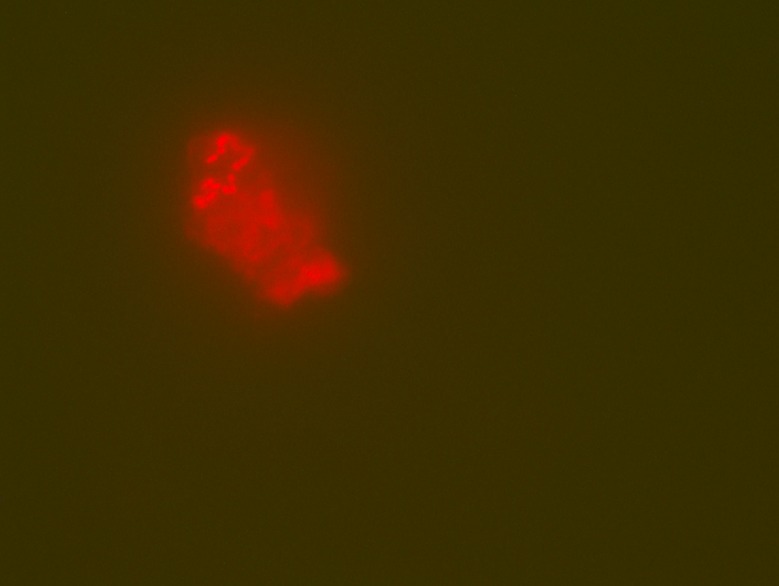
EDTA demineralised Late Cretaceous surface eroded fossil bone at 691 m elevation in Dinosaur Provincial Park showing possible cell clusters as might be expected in a biofilm (image 1).Sample ID as in Appendix 1—table 2: 16B.